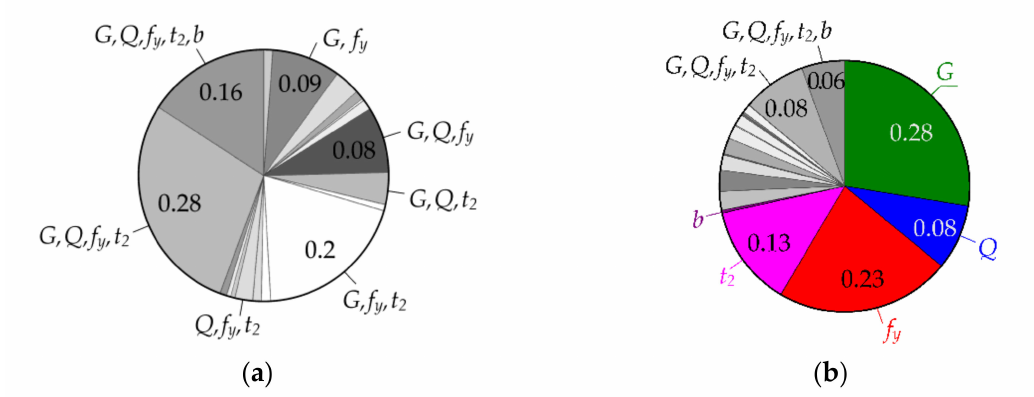
Figure 10. The results of SA for P f = 7.2 × 10 − 5 using: ( a ) C M ( P f ), Equation (23); ( b ) E M ( P f ), Equation (25).